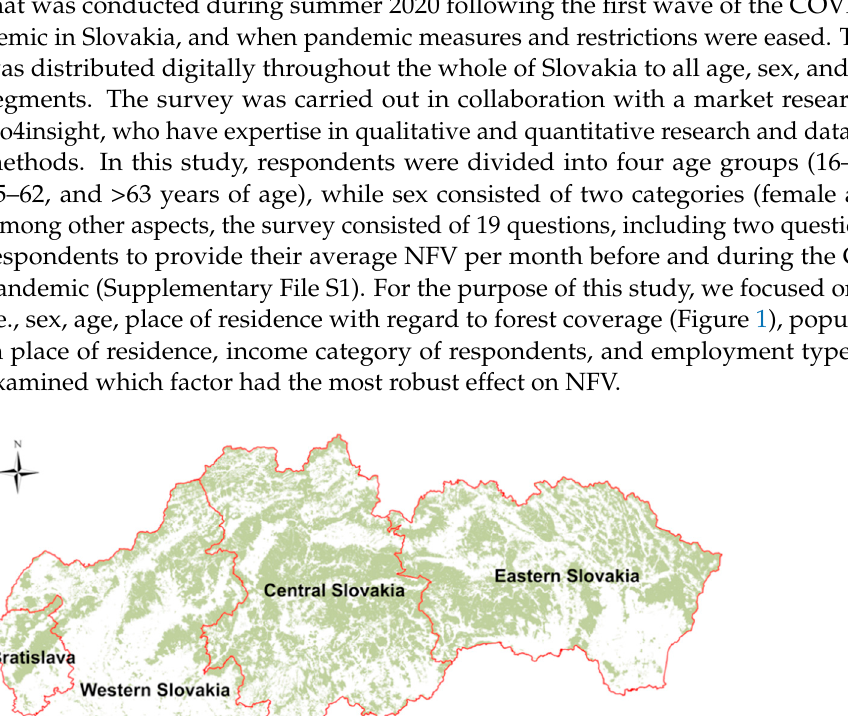
Table 1. Determination of the respondent sample sizes. The required sample sizes were calculated for a 5% margin and 90% confidence level (CL). The realized sample sizes corresponded to the numbers of completed and returned questionnaires. Population size date were obtained from [22].